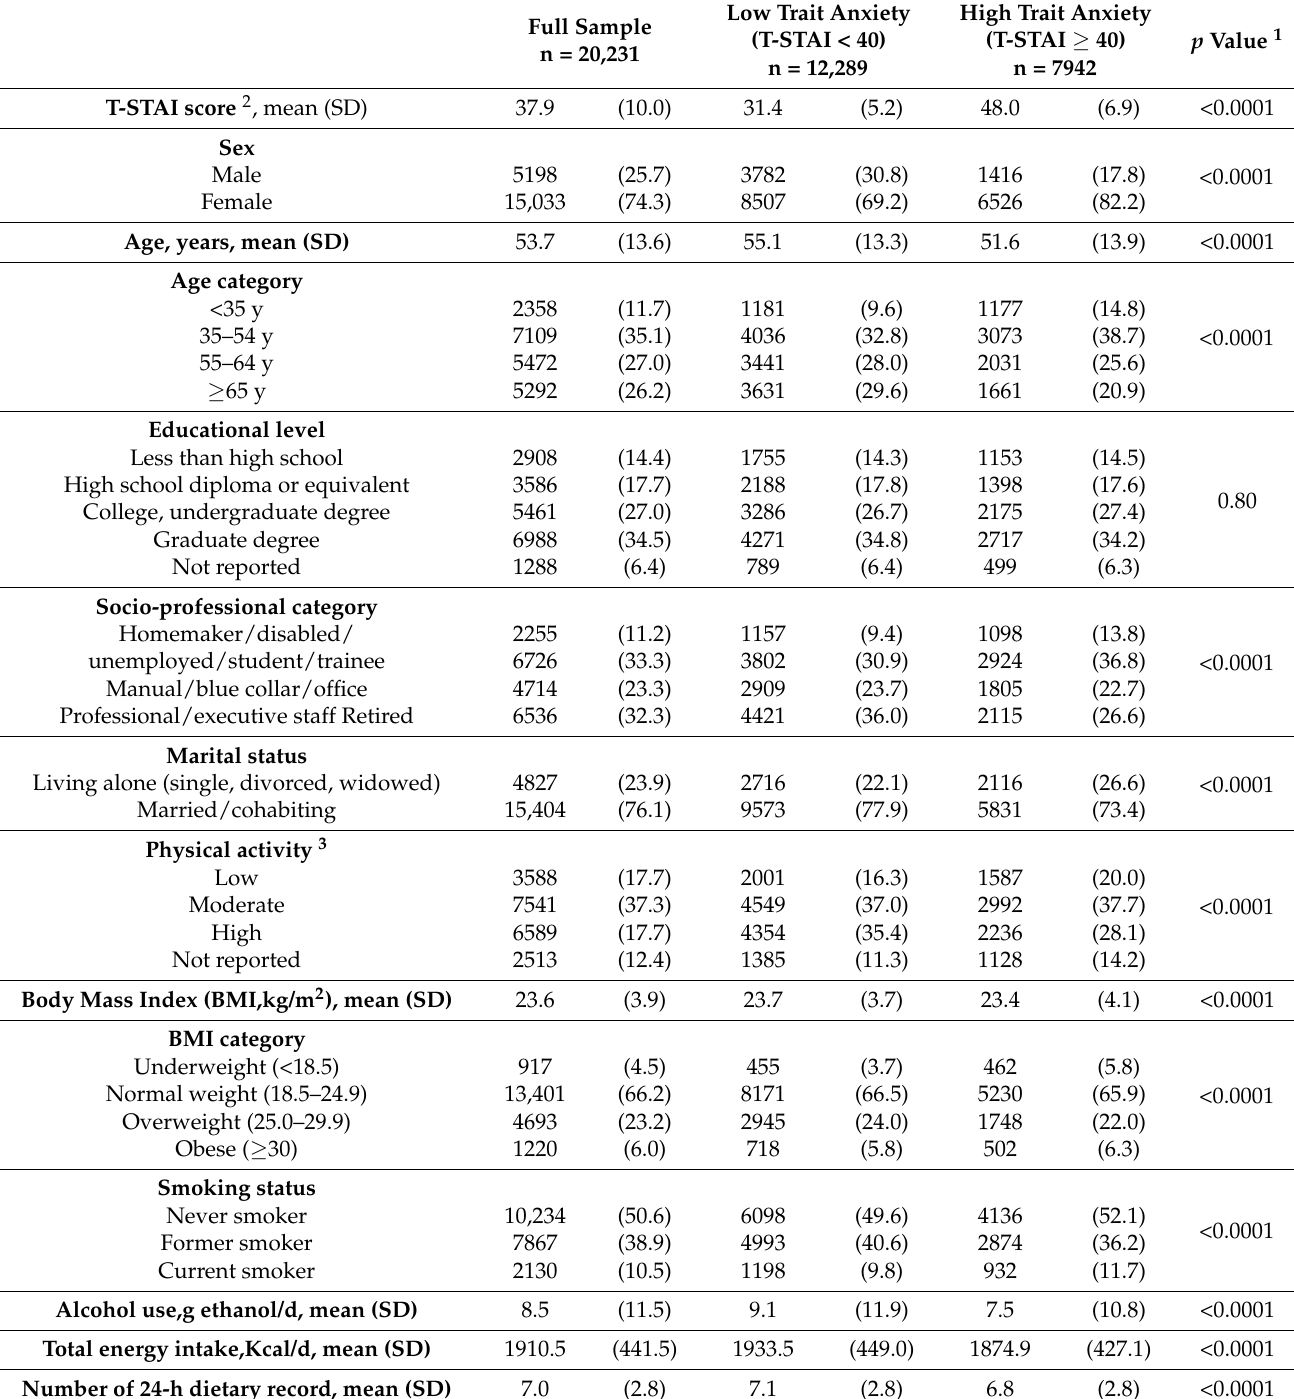
Table 1. Descriptive characteristics of NutriNet-Sant é participants according to trait anxiety status (n =